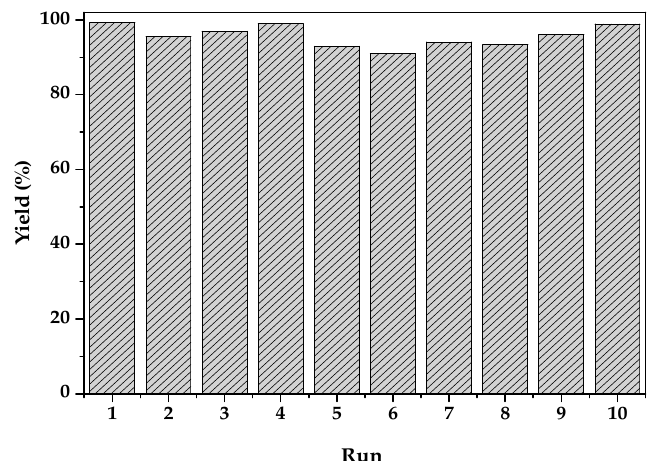
Figure 11. Investigation of catalyst’s stability using 1 g modified 0.27 wt % Pd/ γ ‐ Al 2 O 3 @ASMA catalysts. Reaction conditions: 100 g/L morpholine modified, 1 g p ‐ CNB dissolved in 50 mL ethanol, 80 °C, 600 rpm, 2 MPa H 2 pressure, reaction time: 4 h.